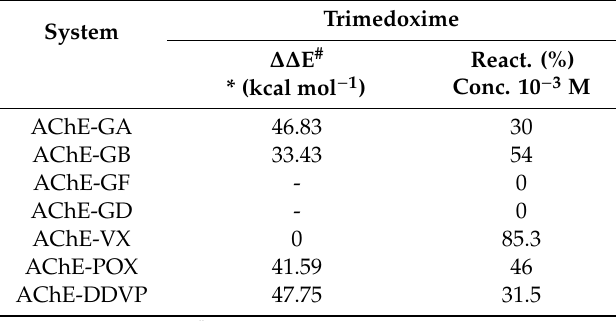
* ∆∆ E # = Relative activation